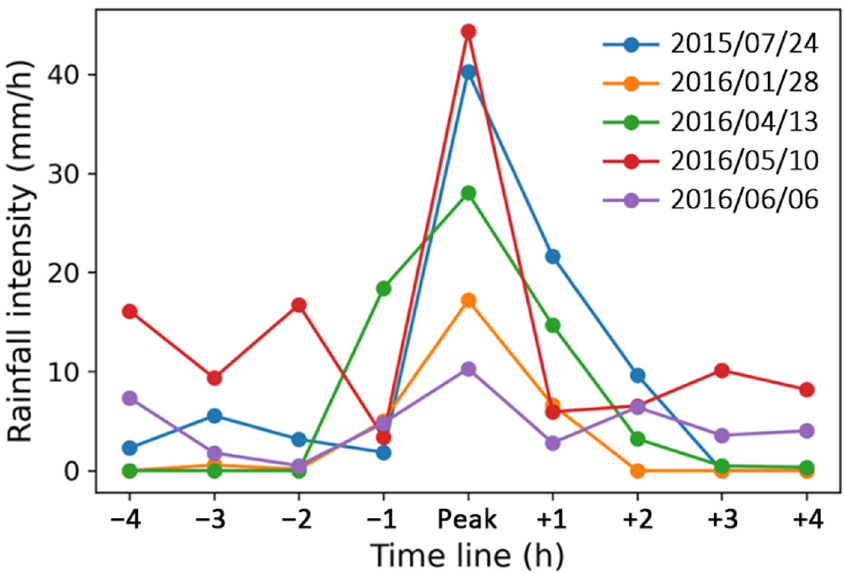
Figure 4. Time distribution of the average rainfall intensity on five rainy days.